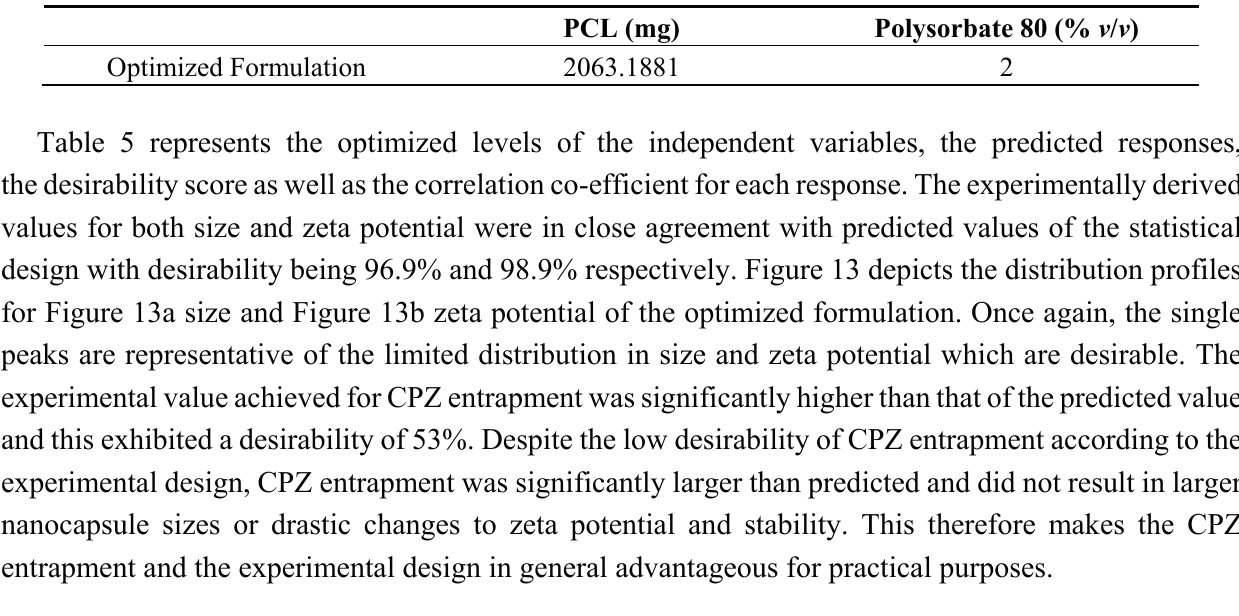
Table 4. Optimized CPZ-loaded, PCL based nanocapsule formulation derived from the response surface method.